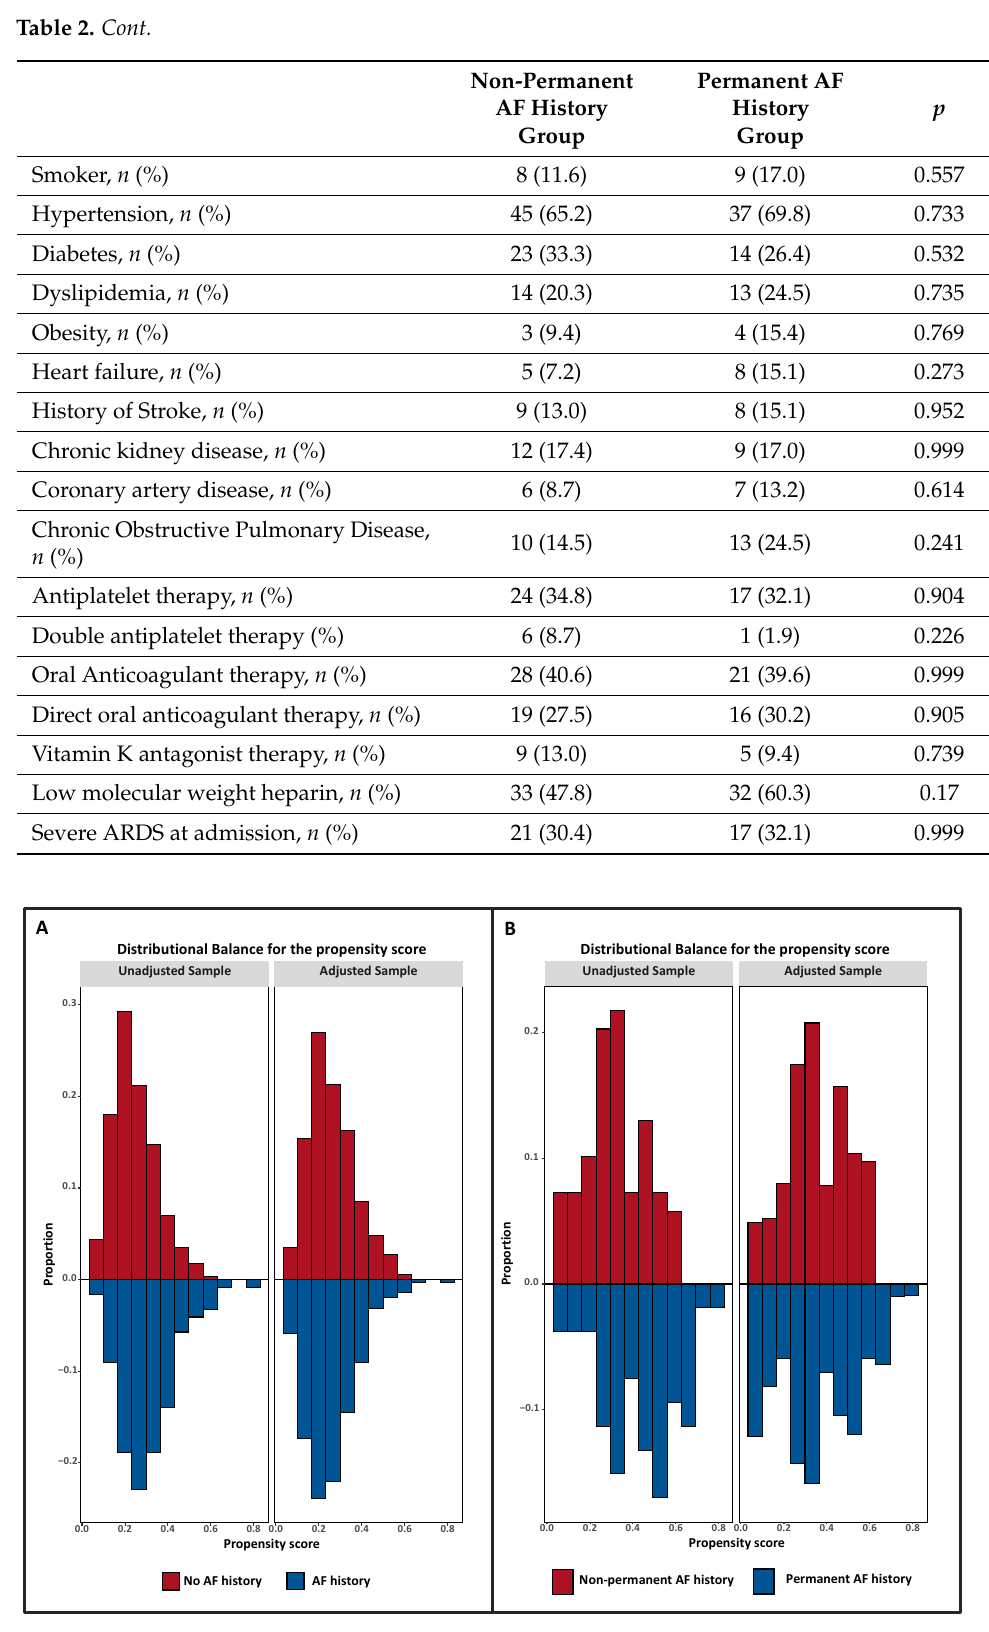
Figure 2. Distributional balance of the propensity score values before and after weighting between no AF history and AF history groups ( A ) and permanent vs. non-permanent AF history groups ( B ). Among overall study population, 124 patients (26.5%) presented with severe ARDS at admission to the emergency department, 169 patients (36.2%) developed severe ARDS during hospitalization and 107 died (22.9%).